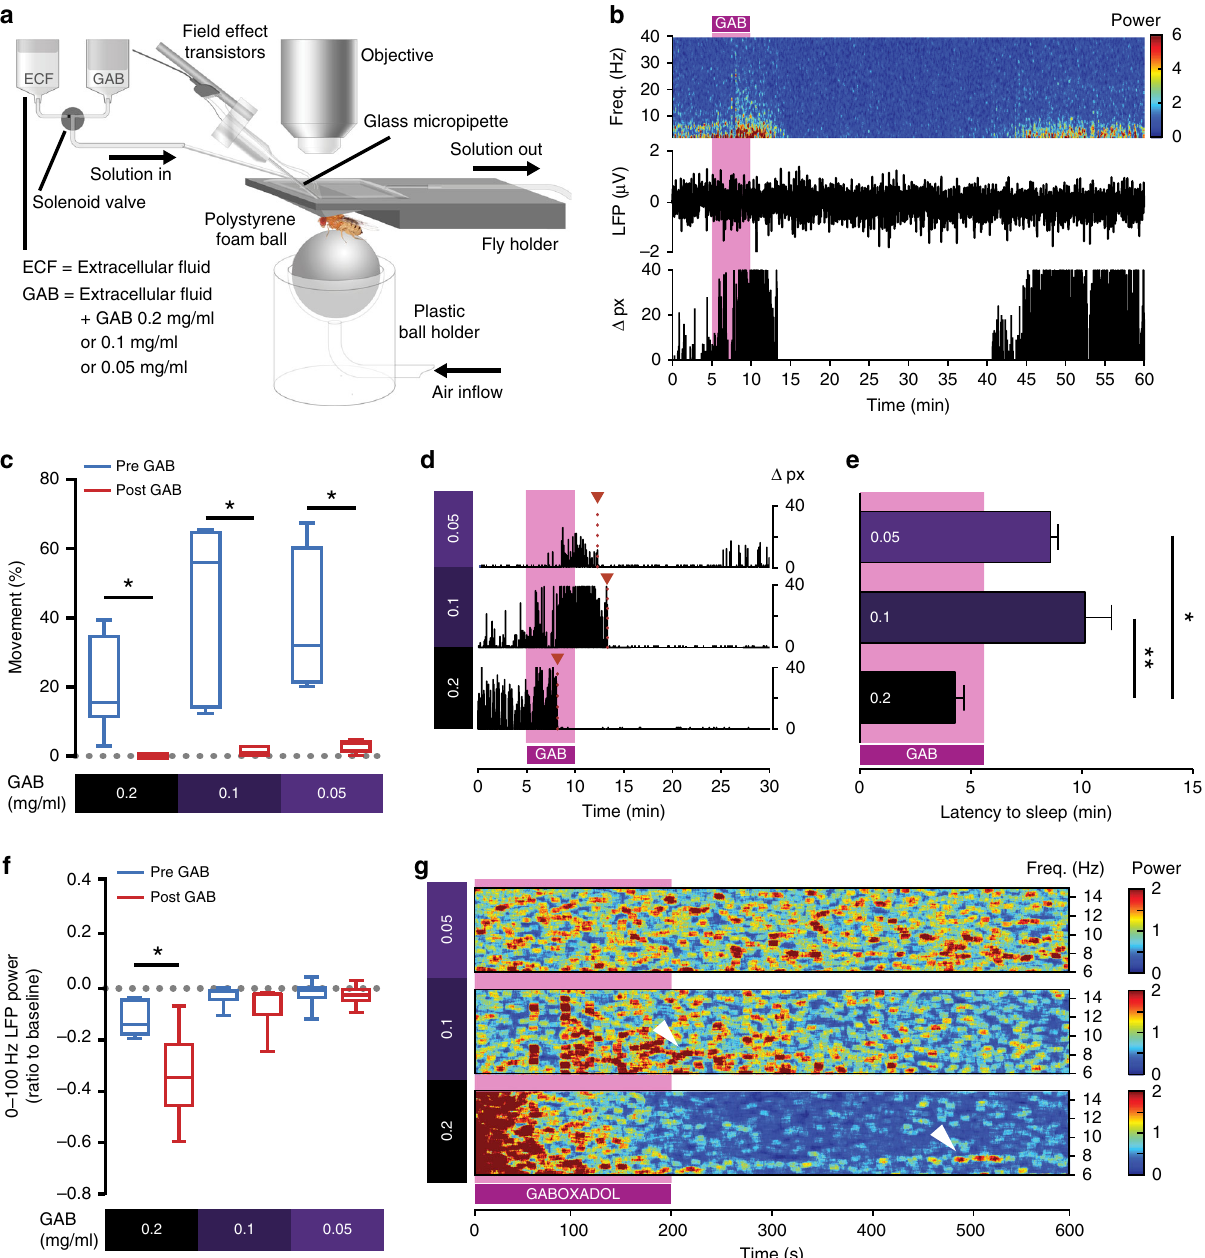
Fig. 4 Gaboxadol-induced sleep is associated with an overall decrease in LFP activity. a In vivo exposed-brain LFP recording setup optimized for pharmacological experiments (see Methods section). b Spectrogram of 2 – 40 Hz LFP power (top) taken from the dFB of a fl y exposed to Gaboxadol (0.1 mg/ml) for 5 min (magenta shade), with corresponding fi ltered LFP signal (middle) and corresponding behavioral activity quanti fi ed as pixel changes (bottom). c Median percentage of time fl y spent moving within 5 min prior (blue) and 5 min after (red) the pre-determined drug onset (see Methods section) (* p < 0.05, by Wilcoxon matched pairs signed rank test between pre- and post-drug). d Representative fl y movement (pixel change) for each concentration of Gaboxadol displaying latency to sleep for each Gaboxadol concentration (indicated on the left). e Averaged latency to sleep ( ± s.e.m.) was signi fi cantly earlier for fl ies exposed to a Gaboxadol concentration of 0.2 mg/ml ( n = 6) compared to both 0.1 mg/ml ( n = 6, ** p < 0.01) and 0.05 mg/ ml ( n = 6, * p < 0.05 by Kruskal – Wallis with Dunn ’ s multiple comparisons between all concentrations). f A signi fi cant decrease in the overall LFP power (0 – 100 Hz) was observed when fl ies were exposed to Gaboxadol 0.2 mg/ml ( n = 6) but not for lower concentrations (* p < 0.05 by Wilcoxon matched pairs signed rank test between pre- and post-drug). g Spectrograms of individual fl y LFP recordings starting 1 min after the onset of Gaboxadol perfusion, for three concentrations of Gaboxadol. White arrows indicate 7 – 10 Hz oscillations. Sample sizes indicate the number of fl ies tested. Images: Melvyn